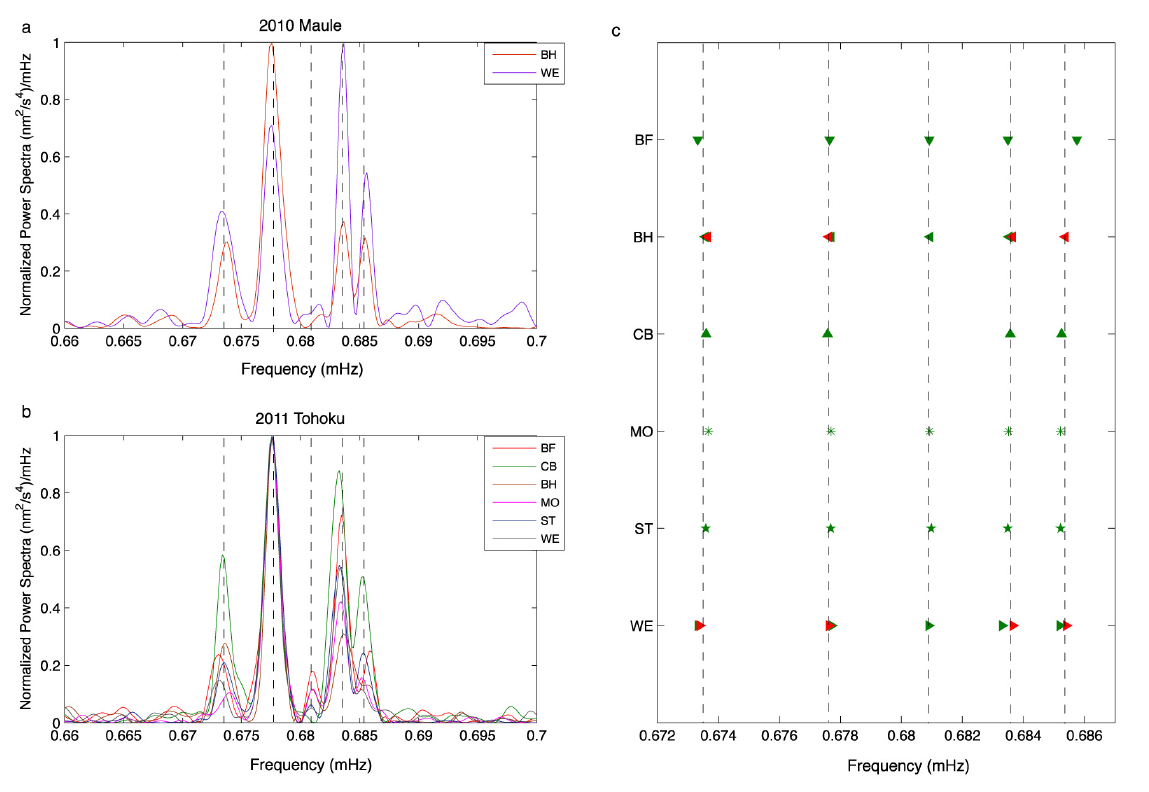
S based on the residual gravity time series after the 2010 and 2011 events. (a) The results of two residual Figure 8. The power spectra of 1 2 gravity time series after the 2010 Maule event; (b) the results of 6 residual gravity time series after the 2011 Tohoku; (c) the estimated fre- quencies from different series. The PREM predictions are denoted by vertical dashed lines.